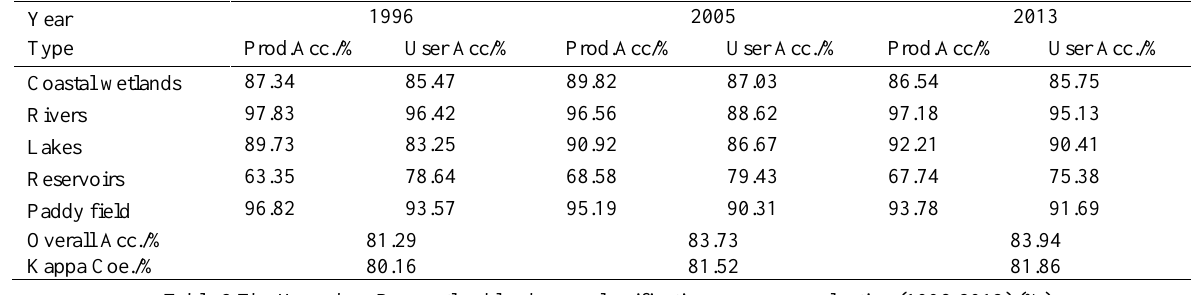
Table 2 The Hangzhou Bay wetland landscape classification accuracy evaluating (1996-2013) (%)